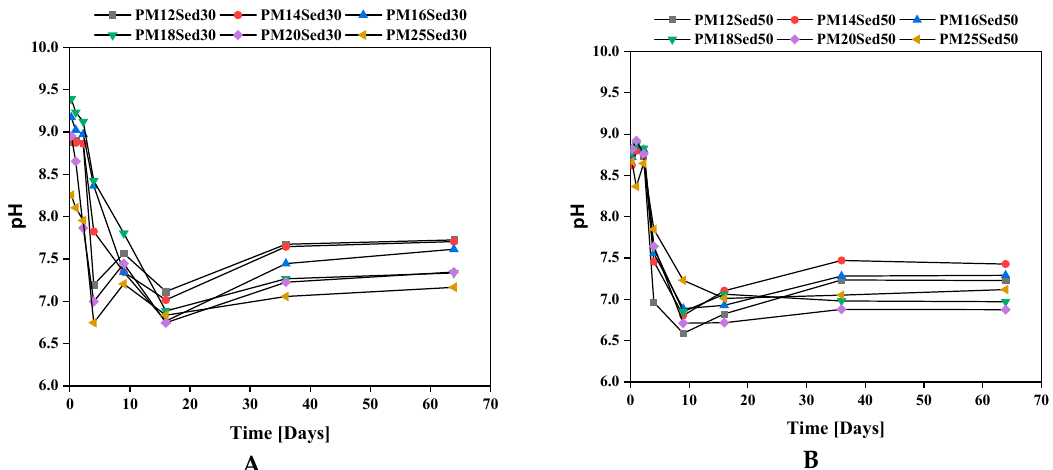
Figure 5. Evolution of pH in eluates of polymer mortar including 30% ( A ) and 50% ( B ) of sediments.